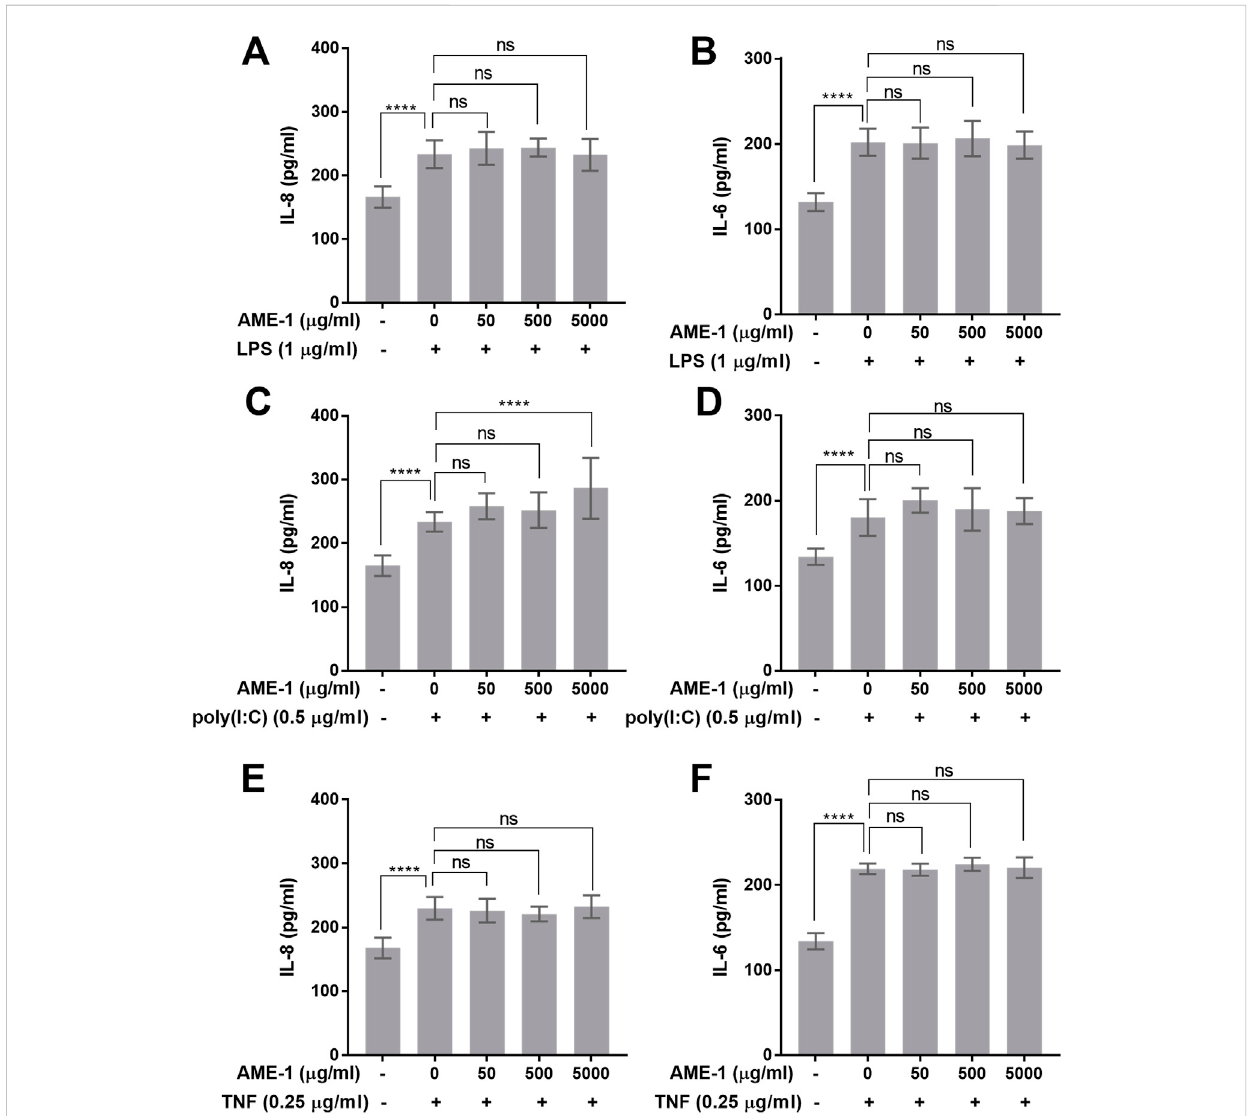
FIGURE 7 AME-1 potentiates poly(I:C)-induced production of IL-8. HMC3 were treated with AME-1 (50 – 5,000 μ g/mL) or left untreated for 3 h and stimulated with 1 μ g/mL LPS, 0.25 μ g/mL TNF, or 0.5 μ g/mL poly(I:C) for 24 h. (A, B) AME-1 has no effect on LPS-induced production of IL-8 or IL-6. (C, D) AME-1 potentiates poly(I:C)-induced production of IL-8 but has no effect on IL-6. (E, F) AME-1 has no effect on TNF-induced production of IL-8 or IL-6. Data presented as mean ± SEM for n = 3. Statistical signi fi cance was calculated using Two-Way ANOVA with Tukey post hoc analysis: p ≤ 0.0001